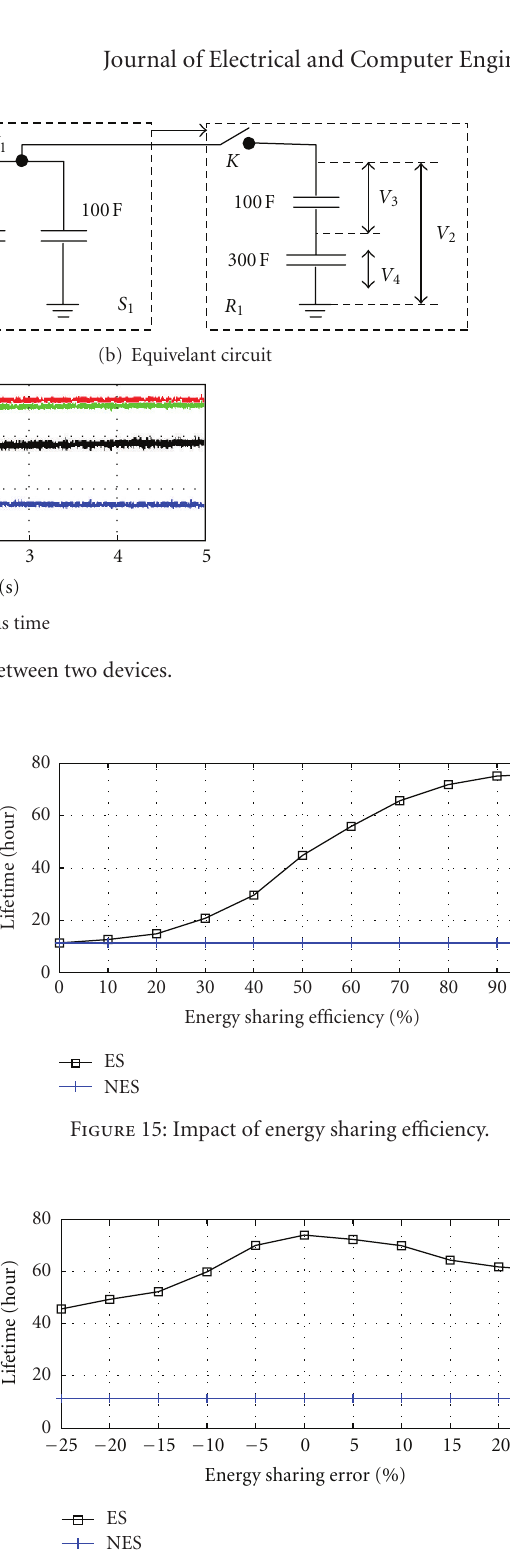
Figure 16: Impact of energy sharing